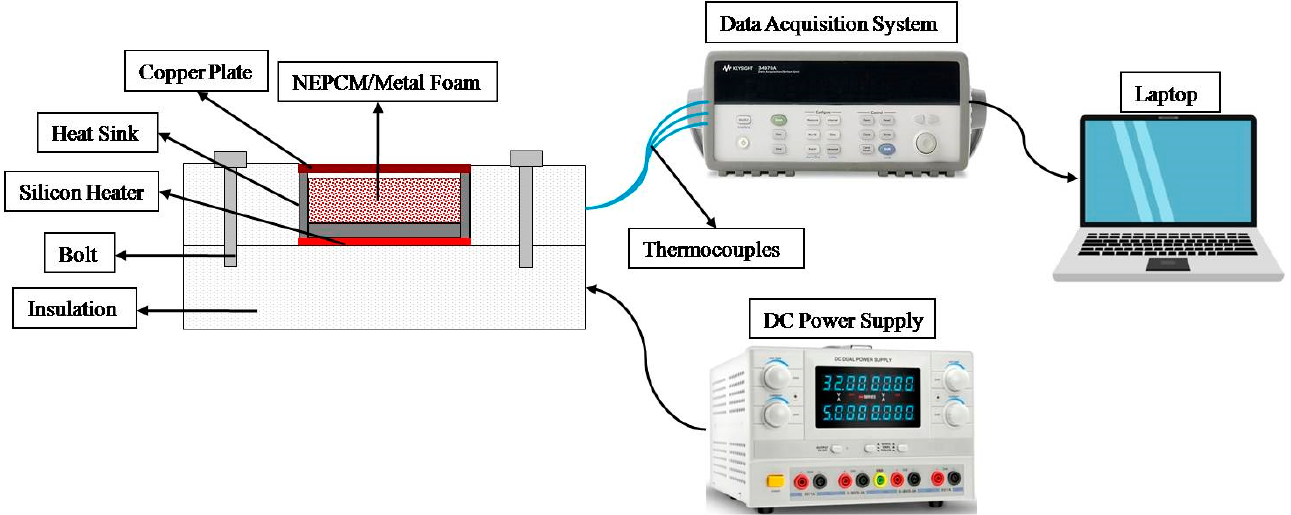
Figure 1. Schematic Diagram of Experimental Setup.